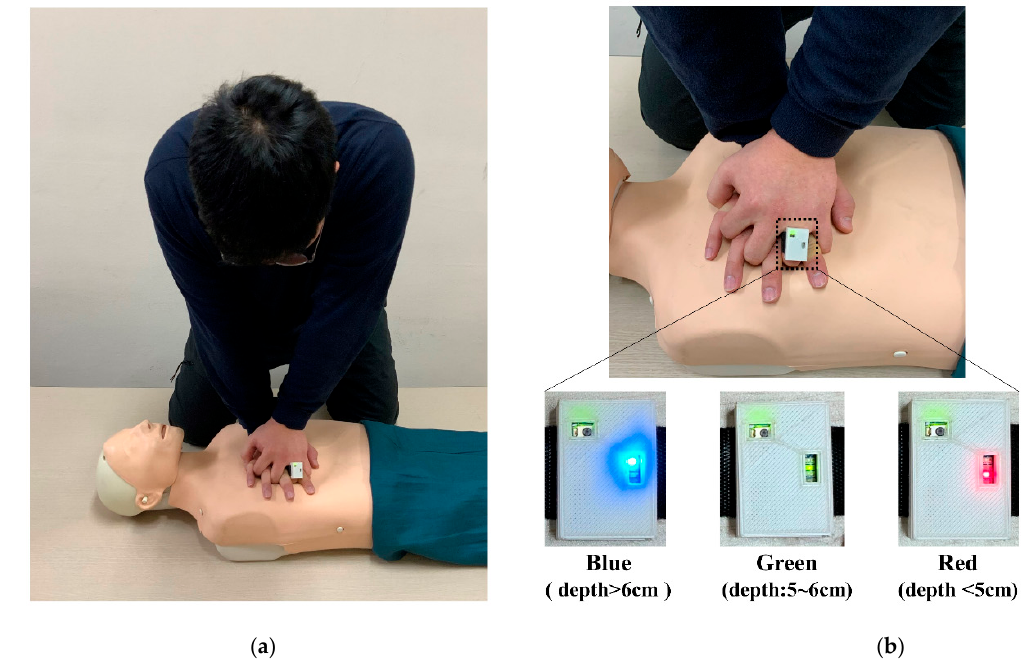
Figure 1. Visual feedback of the smart-ring device. ( a ) CPR posture and environment during chest compression. ( b ) Three LED lights were linked to the depth.